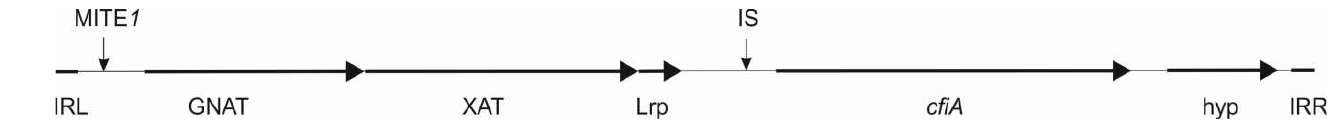
Figure 1. An updated scheme of the cfiA ’element’. IRL and IRR inverted repeats bordering the element; ‘GNAT’—ORF coding a Gcn5-like acetylase protein; ‘XAT’—another acetylase protein; Lrp—a short ORF coding for a lysine-rich peptide; hyp—an ORF coding for a hypothetical protein; MITE 1 with arrow—possible insertion of miniature transposable element 1; IS with arrow—possible insertion of a cfiA -activating IS element.